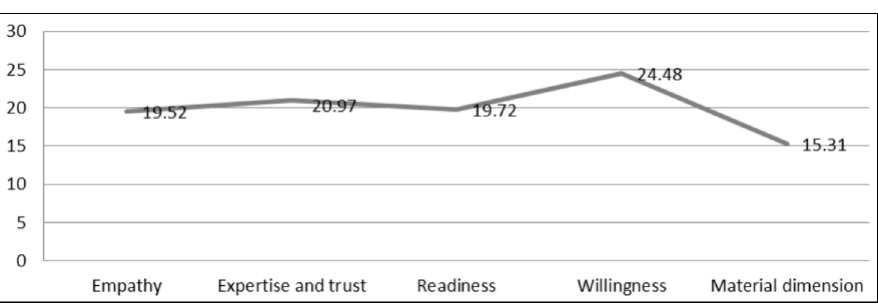
Figure 2. Significance of quality dimensions according to